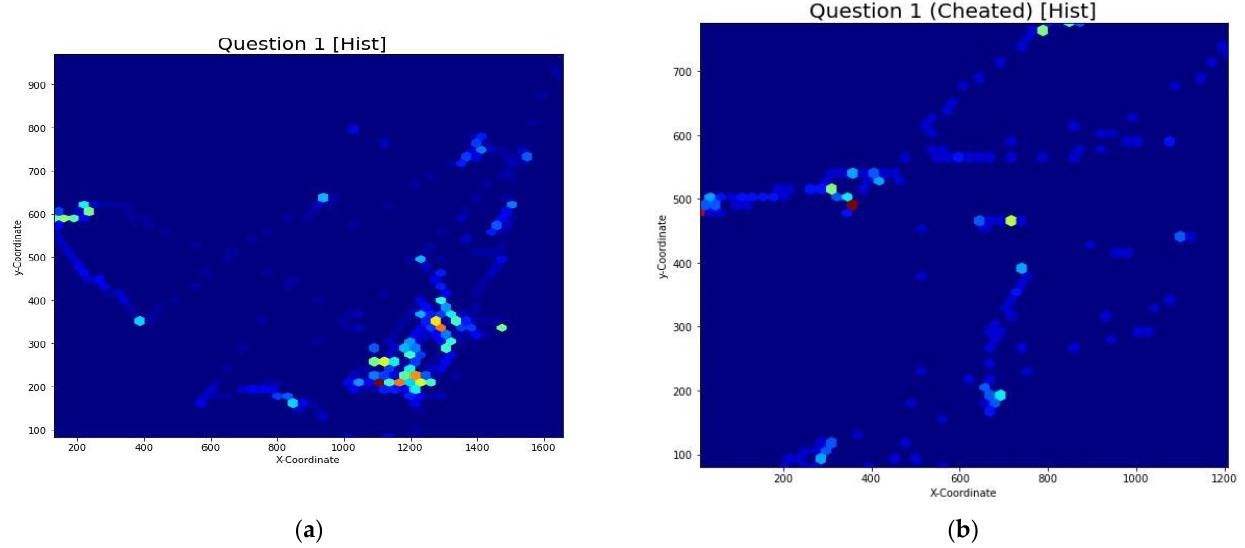
Figure 6. A histogram of raw mouse movements showing the difference in the frequency of move- ments is as follows: ( a ) a KDE plot of question 1 answered by students without cheating; ( b ) a KDE plot of question 1 answered by students who are allowed to cheat.